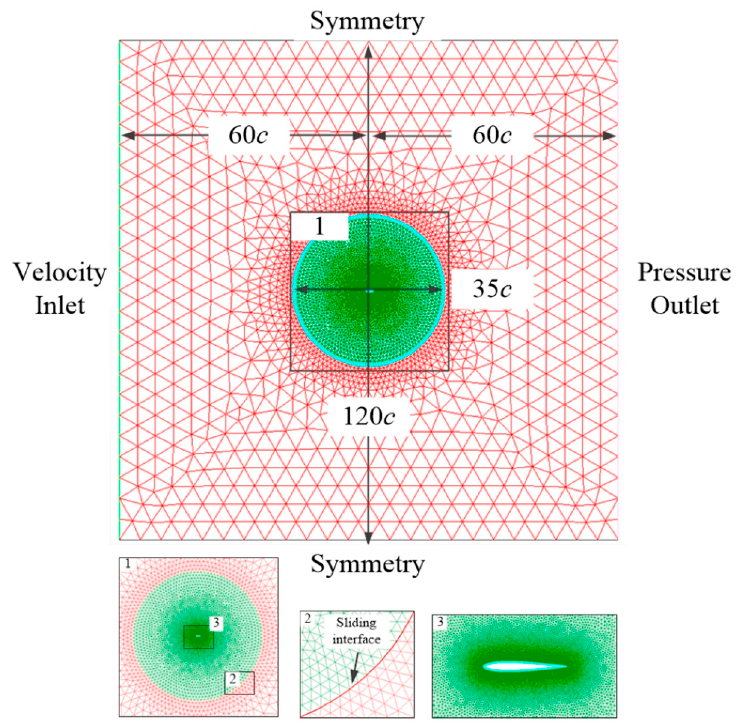
Figure 3. 2D URANS mesh details and boundary conditions for the flapping